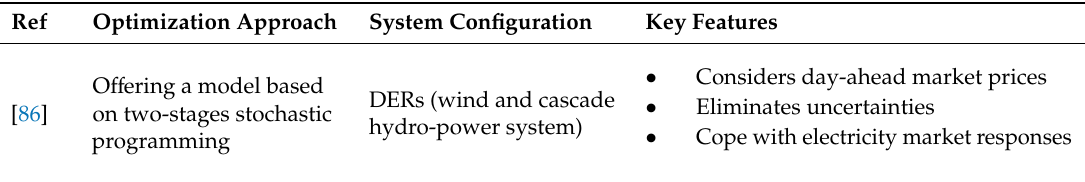
Table 2. A comparative analysis among di ff erent o ff ering models for virtual power plants.